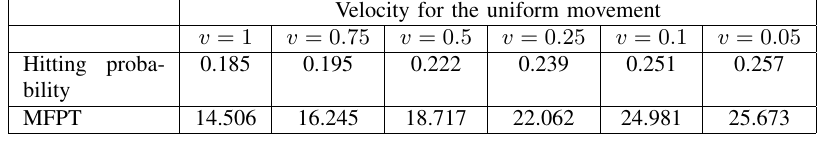
T HE HITTING PROBABILITY AND THE MFPT DEPENDING ON THE POSITION OF THE VELOCITY OF THE UNIFORM MOVEMENT